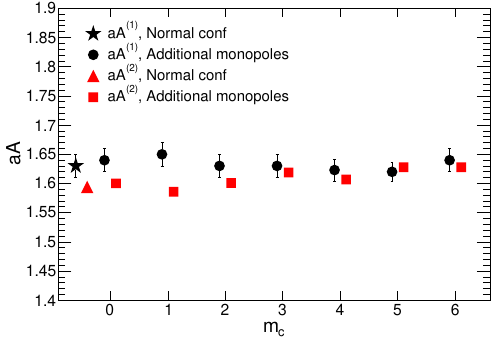
Figure 11 . Comparisons of the (cid:12)tting results of the slopes aA (1) and aA (2)